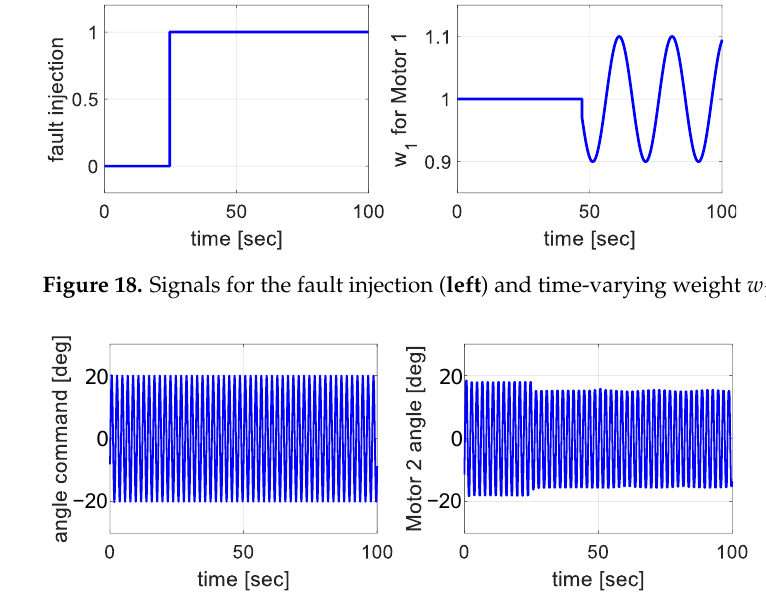
Figure 19. Command angle (left) and measured angle (right).